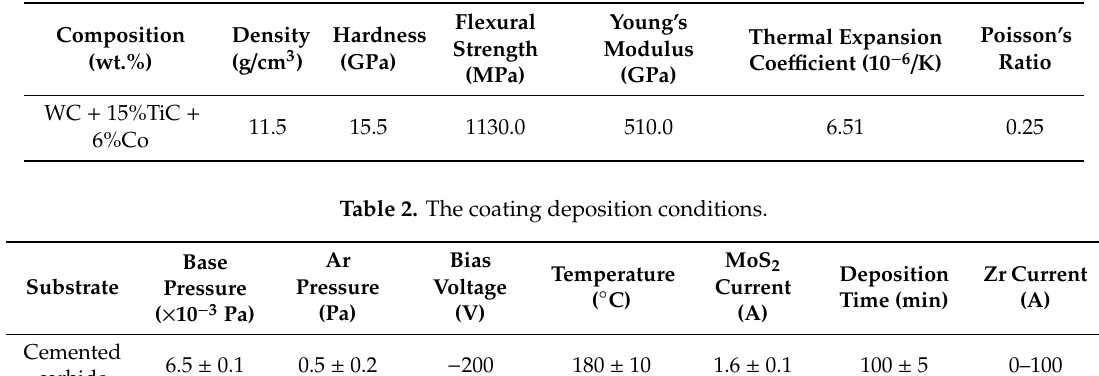
Table 1. Properties of the cemented carbide material.